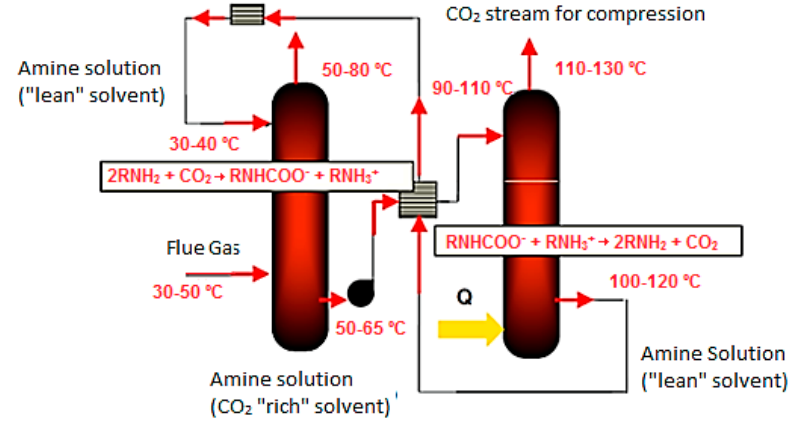
Figure 1. Process diagram for CO 2 absorption using amines with the respective temperatures and reactions